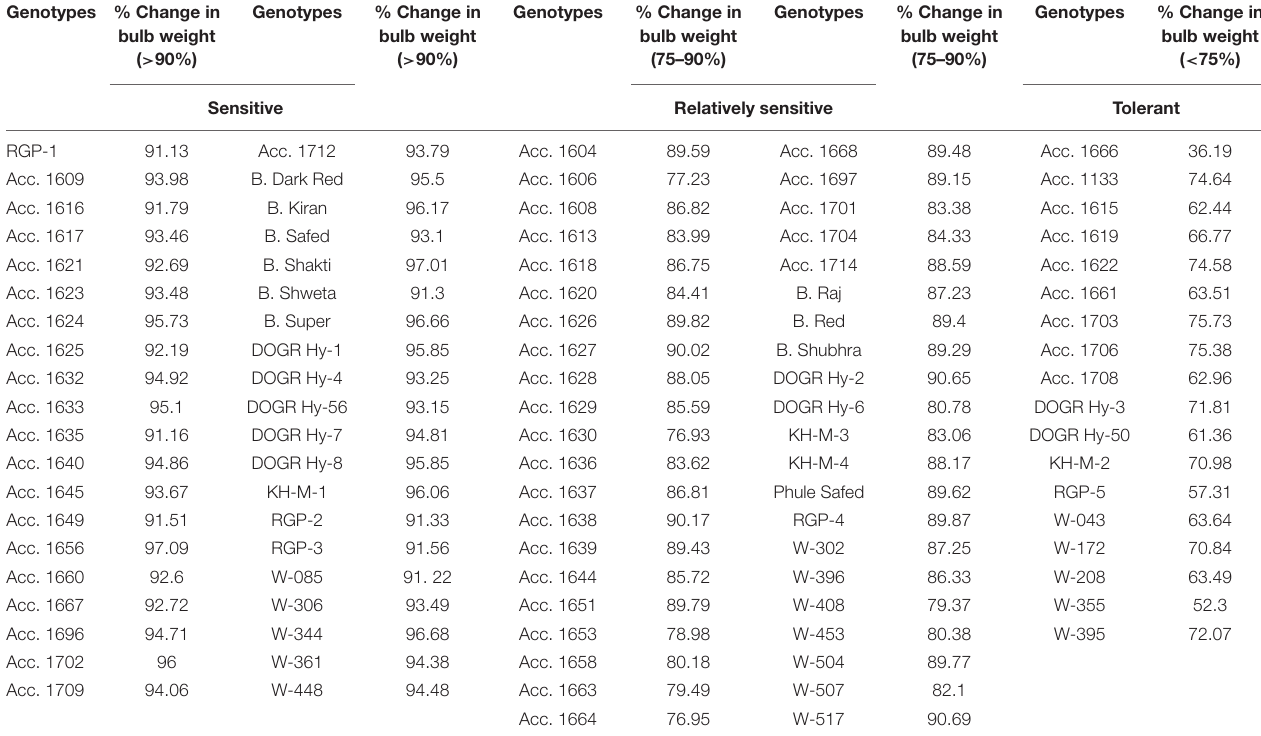
TABLE 3 | Genotypes grouped based on percent change in bulb yield under waterlogging stress. Genotypes % Change in bulb